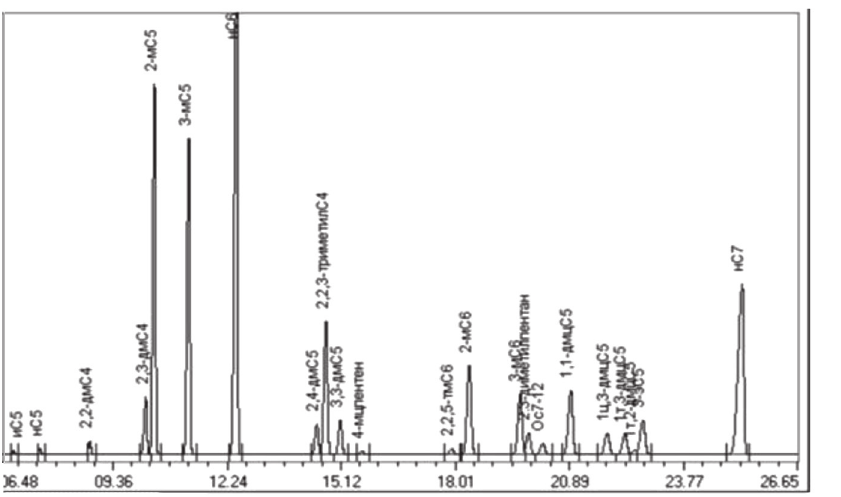
Fig. 5 – Typical chromatogram of the final product of gasoline fraction hydrogena- tion: 2.2-dimethyl